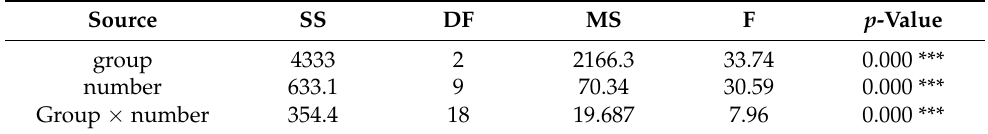
Table 3. The results of two-way repeated measured ANOVA.